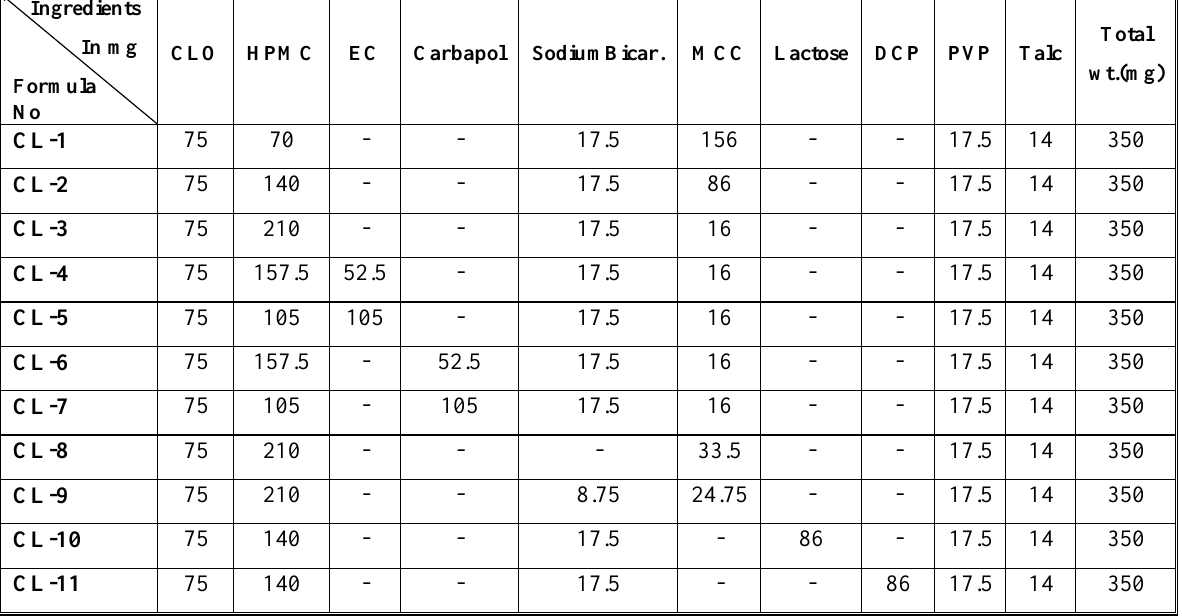
Table2: Different formulas of clopidogrel tablet as sustained release